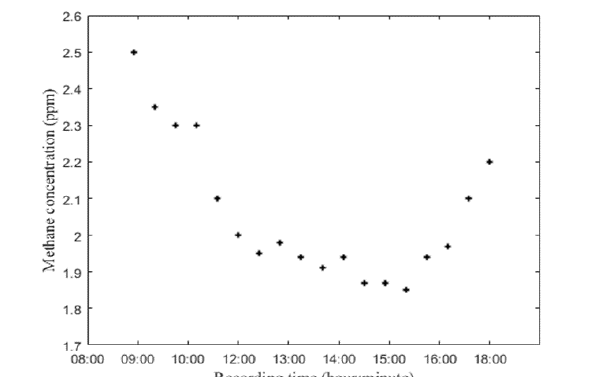
atmospheric methane